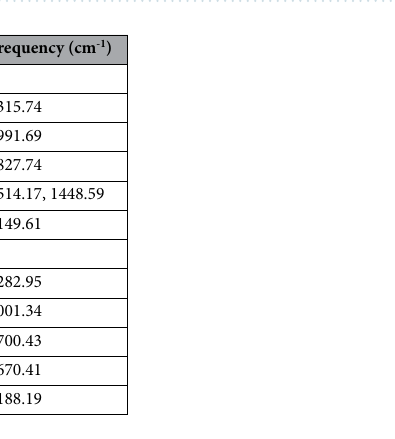
Table 2. IR interpretation of 4.0G and 3.5G PAMAM dendrimers.